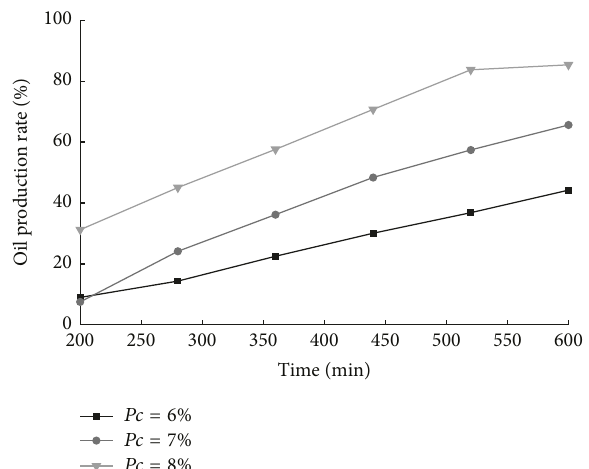
Figure 11: Oil production rate for different initial oil content.